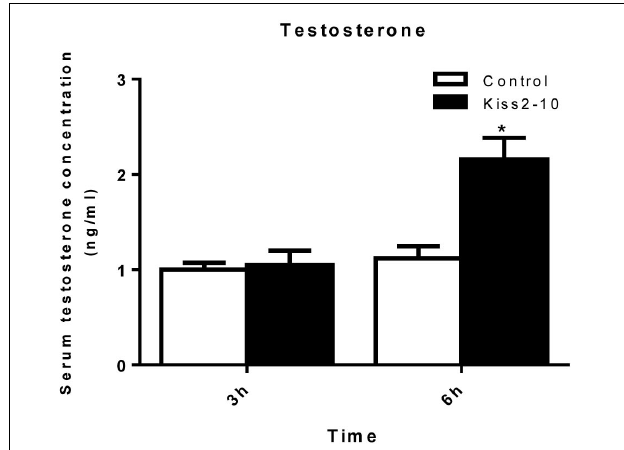
FIGURE 9 | Serum testosterone concentrations post-injection of seahorse Kiss2-10. Data are presented as means ± SEM. Asterisks denote significant differences between different treatments ( P <